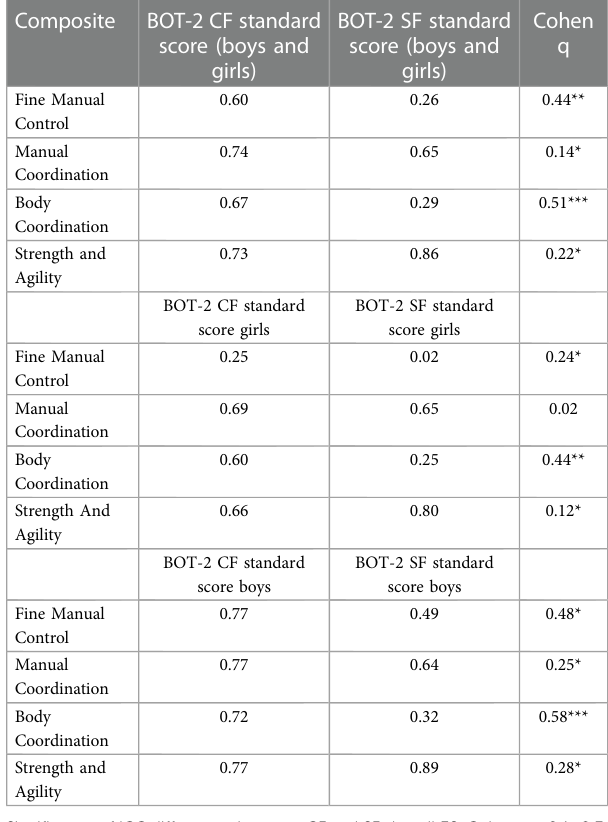
TABLE 2 Intraclass correlation coef fi cient differences between composite scores and BOT-2 CF and BOT-2 SF standard scores – total, boys, girls.